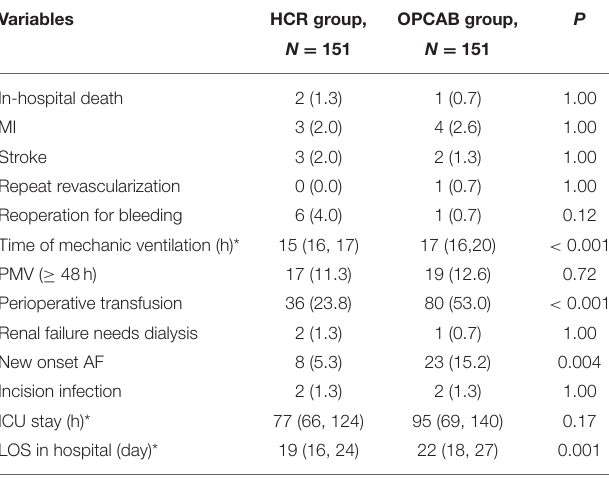
TABLE 4 | In-hospital outcomes of matched patients who underwent HCR and OPCAB.